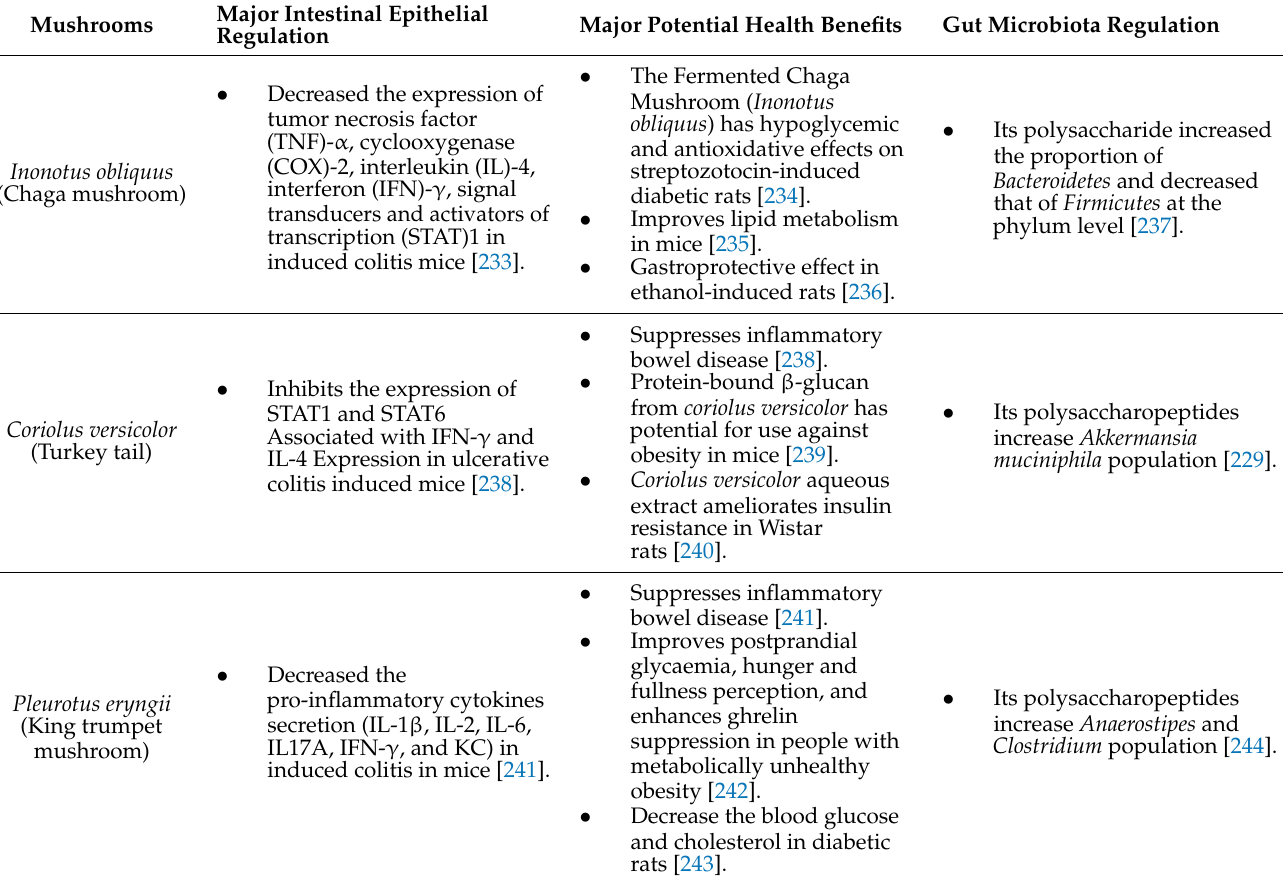
Table 4. Major mushrooms that help leaky